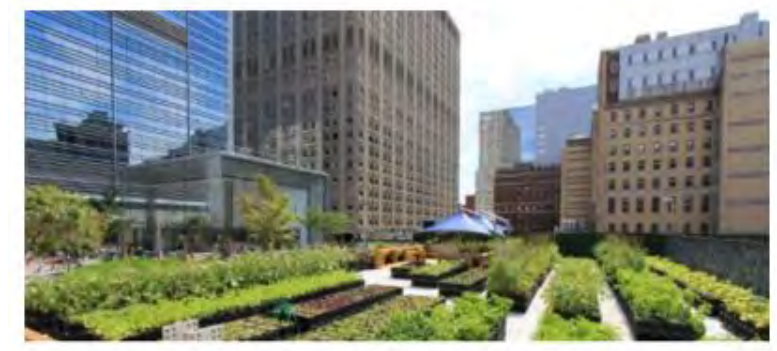
Figure 13. Urban agriculture within dense city